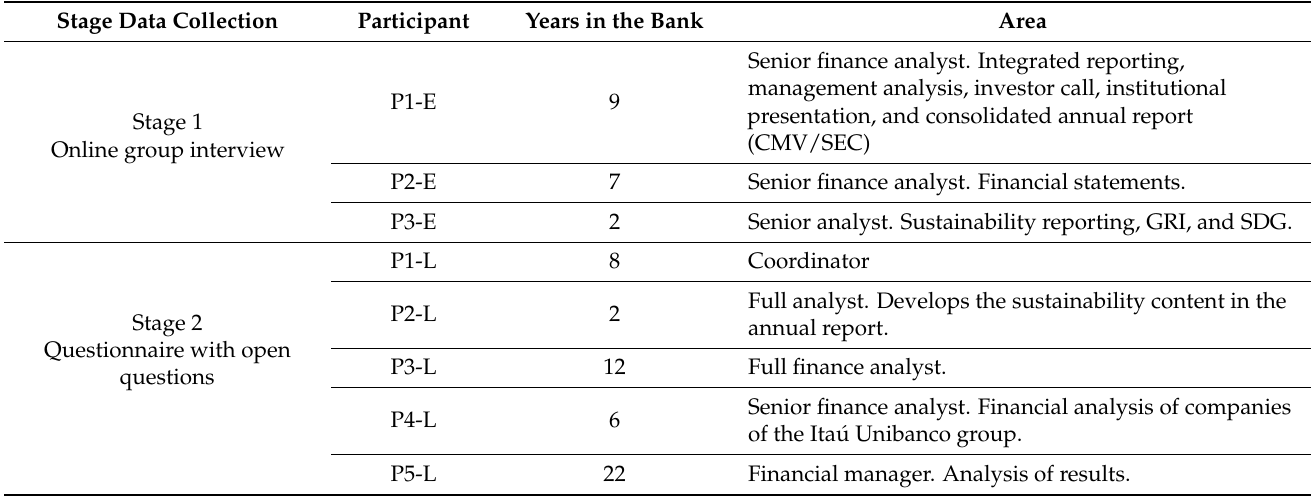
Table 3. Participants.